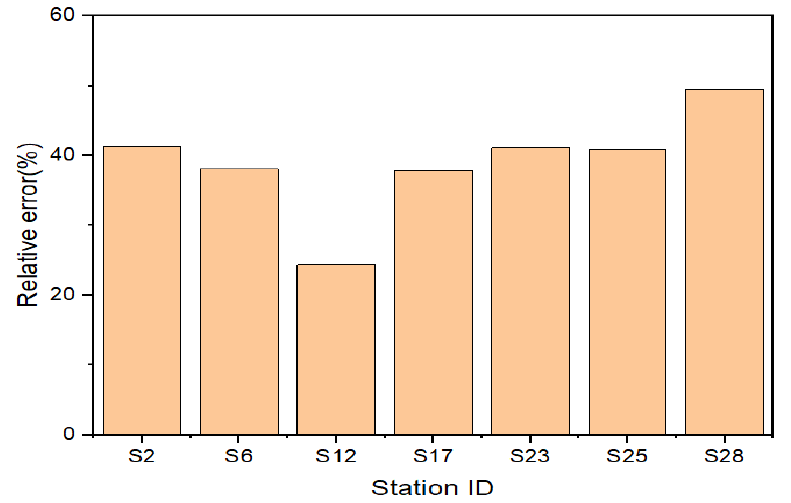
Figure 11. Average relative error for the water quality parameter total nitrogen (TN) at Taihu, China.